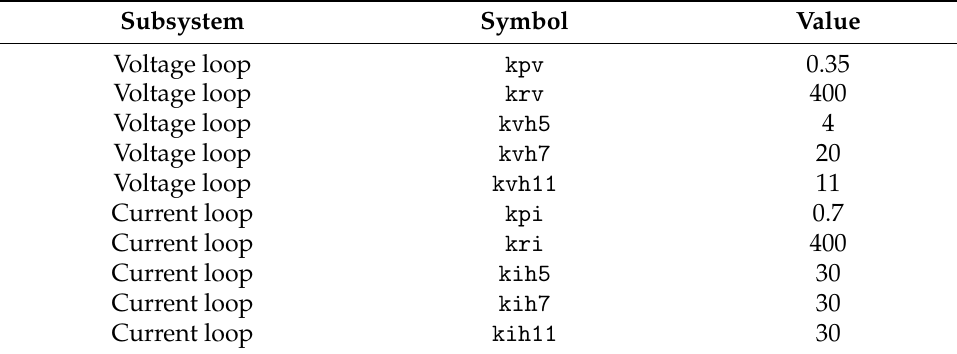
Table 4. Inverter controller